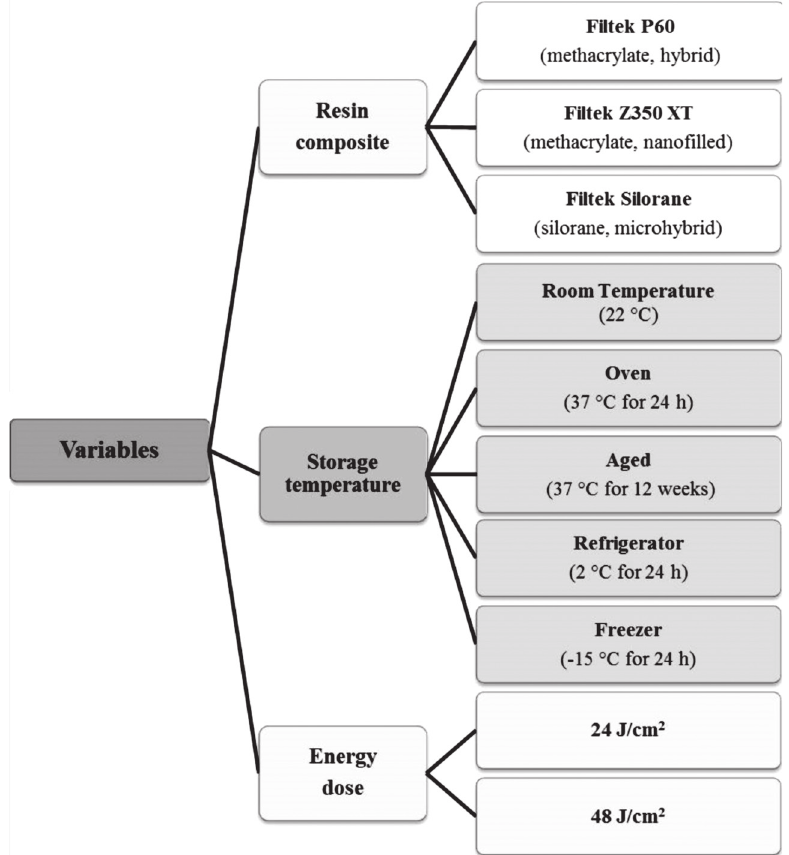
Figure 2- Schematic representation of the experimental